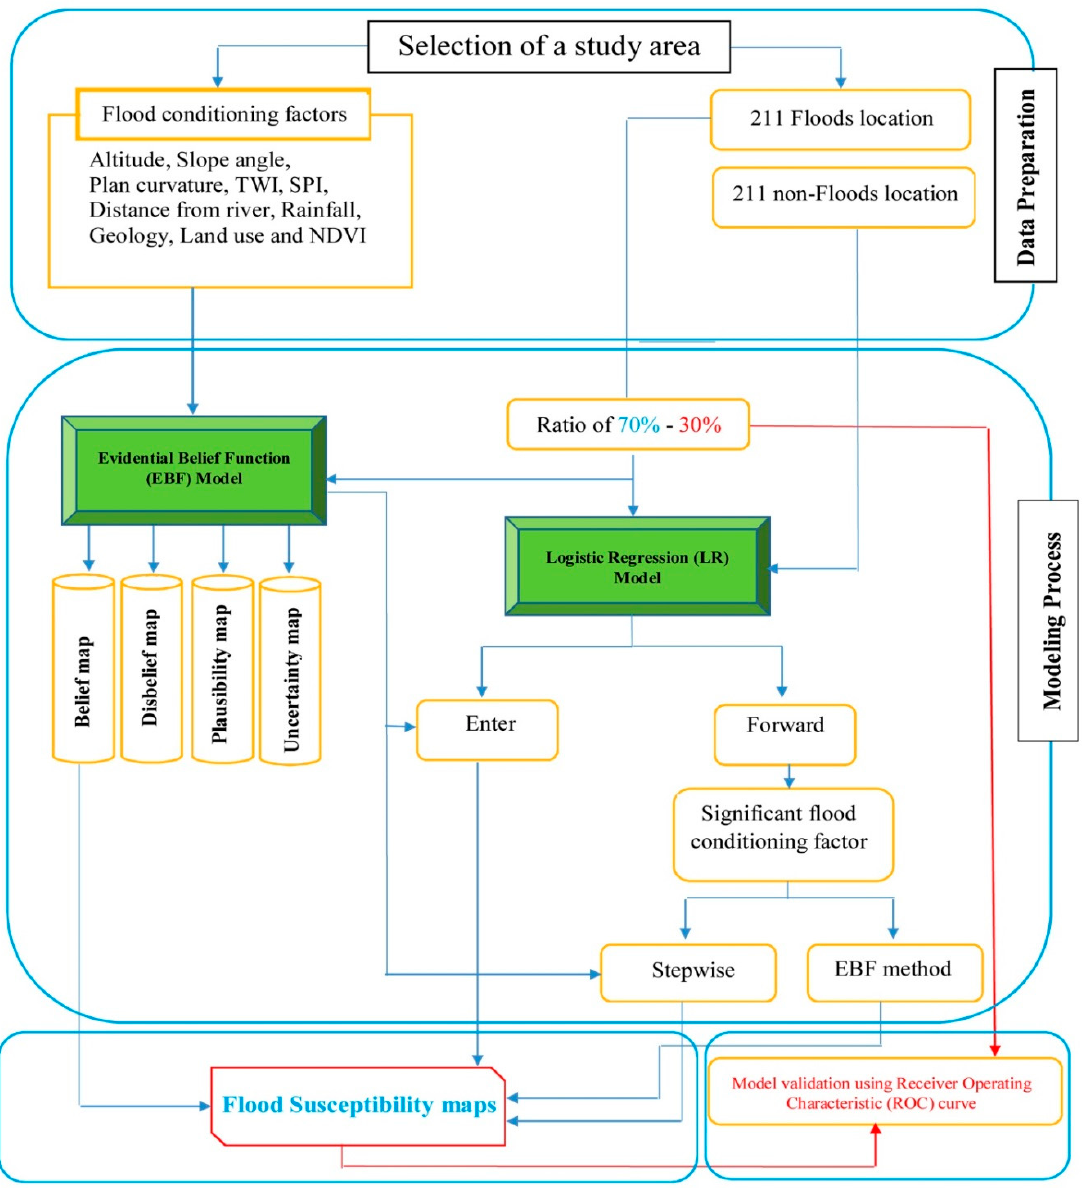
Figure 4. Flow chart of the adopted research methodology used to create flood susceptibility maps of the Haraz Catchment.